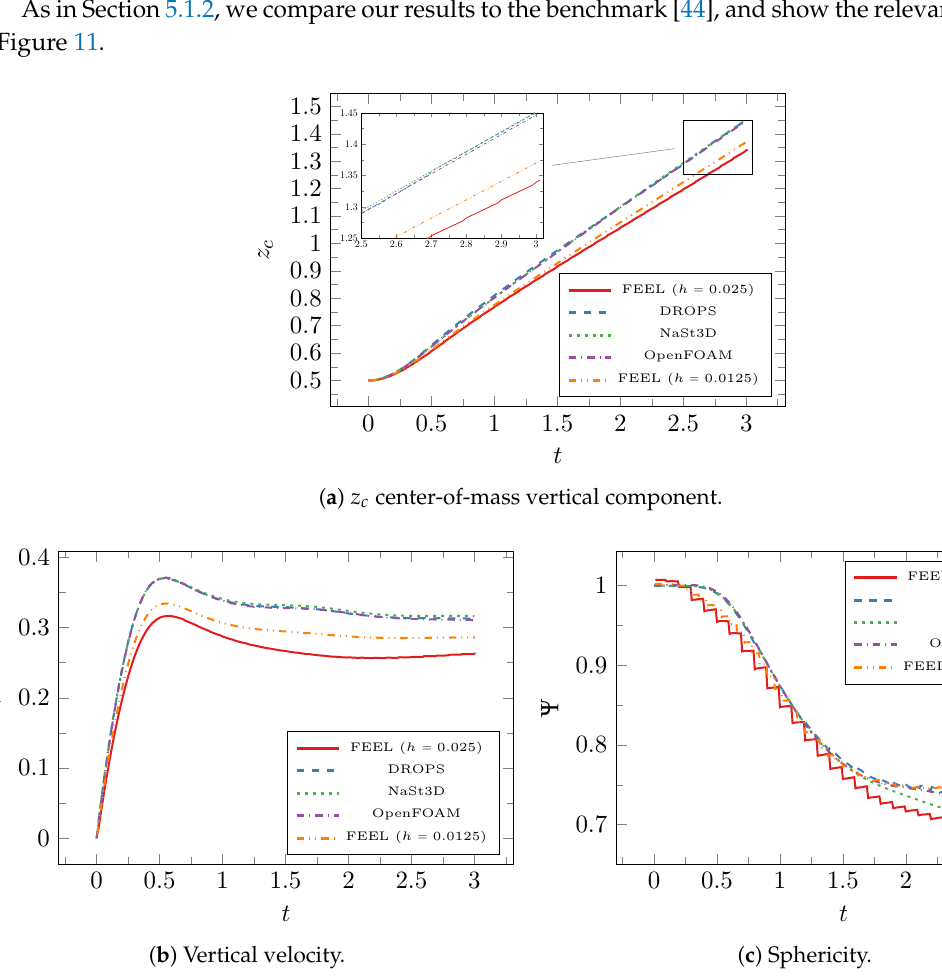
Figure 11. Comparison between our results (denoted FEEL) and the ones from [44] for the test case 2 (the skirted